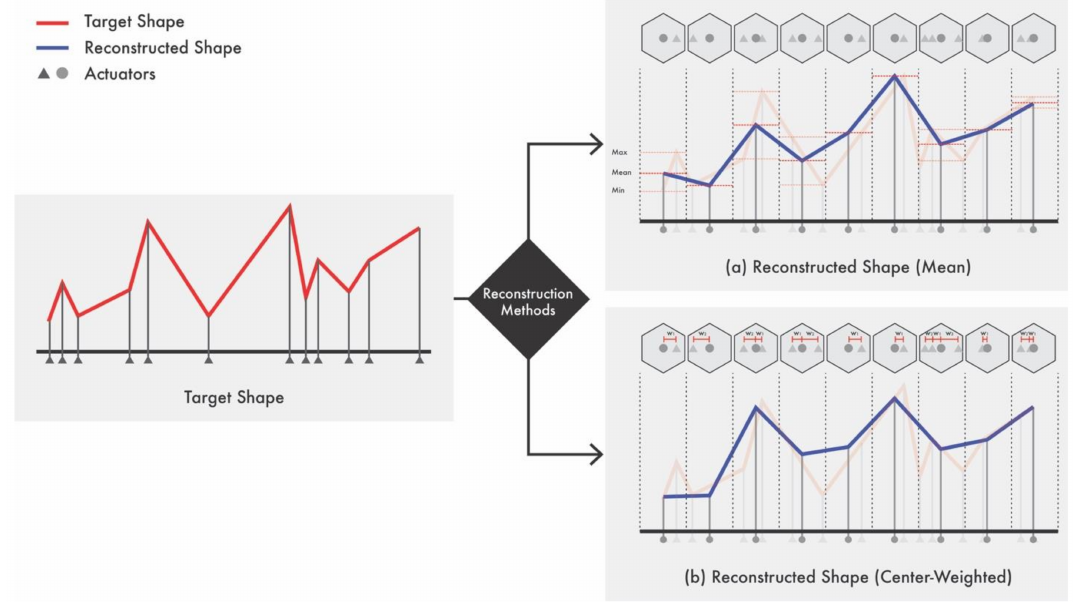
Figure 4. Process of arranging vertices according to the position of the limited actuating